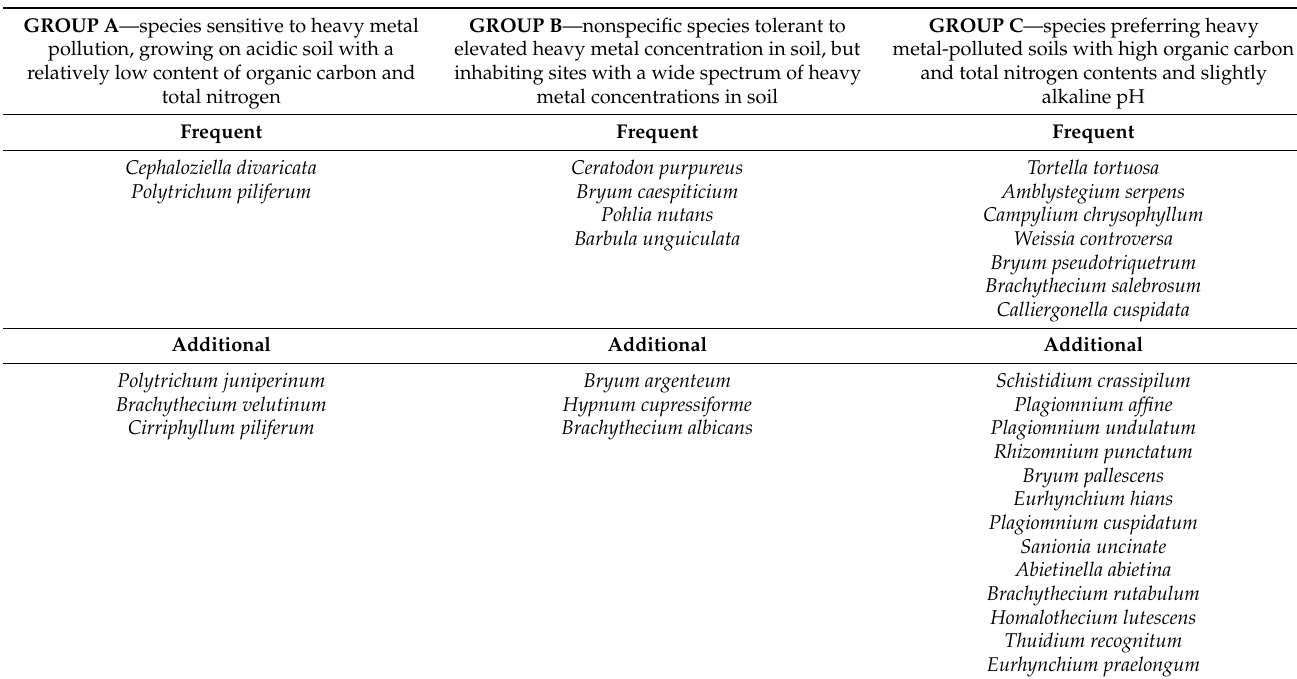
Table 4. Defined three groups of bryophytes (A, B, and C) according to their sensitivity to heavy metal pollution.